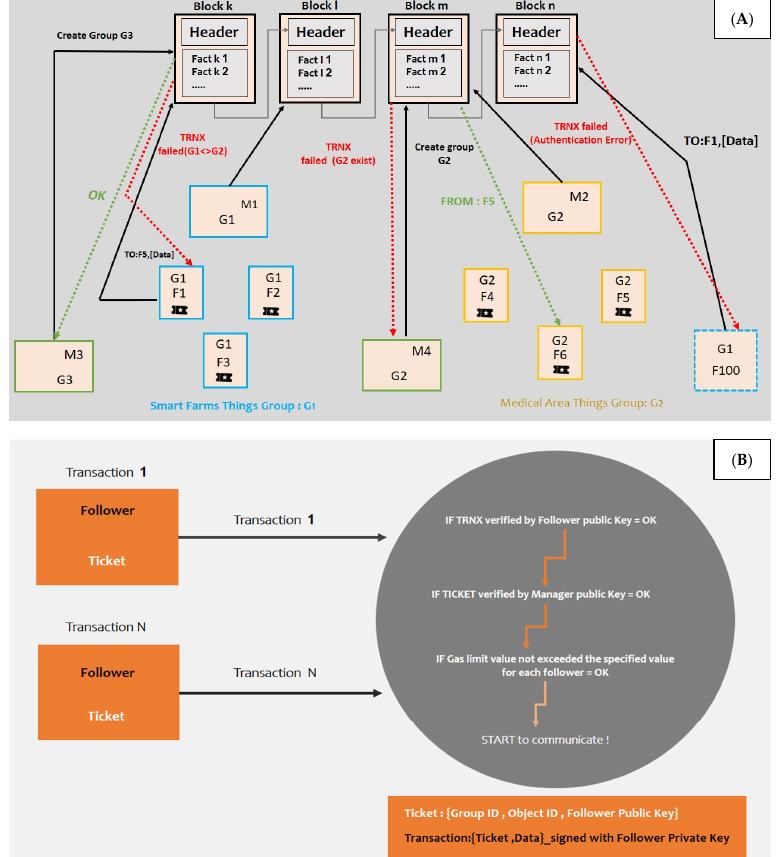
Figure 2. ( A ) Initialization phase; ( B ) Communication phase.